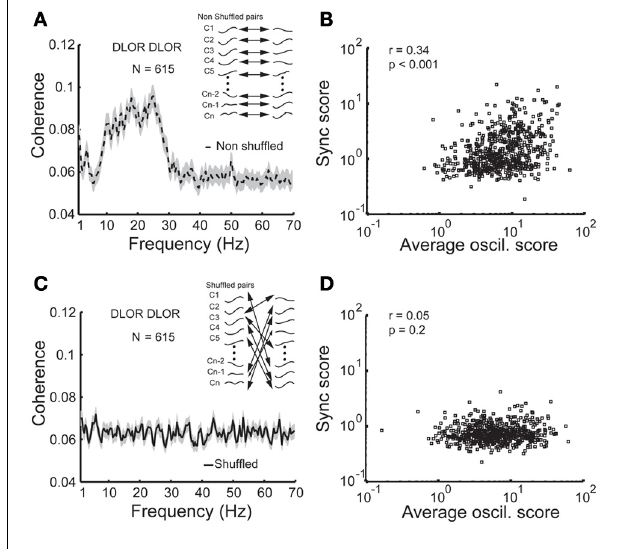
FIGURE 5 | Synchronization is no longer apparent between non-simultaneously recorded (shuffled) STN DLOR pairs. (A) A significant average coherence between non-shuffled pairs within the STN DLOR. N = 615 represents the number of DLOR-DLOR pairs. (B) Scatter plot of synchronization (sync) and oscillation (oscil) scores in the STN DLOR reveals that the two measures are correlated. Each square represents the synchronization ( Y -axis) vs. average (arithmetic mean) of the two oscillation scores of one of the 615 pairs within the DLOR. r is the Spearman correlation coefficient and p is the probability that r = 0 (no correlation between the scores). (C) Synchronization is no longer seen between non-simultaneously recorded (shuffled) STN DLOR-DLOR pairs. Inset: Schematic illustration of the shuffling procedure. The shuffling procedure was repeated 10,000 times for each pair. (D) Scatter plot of shuffled oscil-sync score values. Same conventions as in (B) .